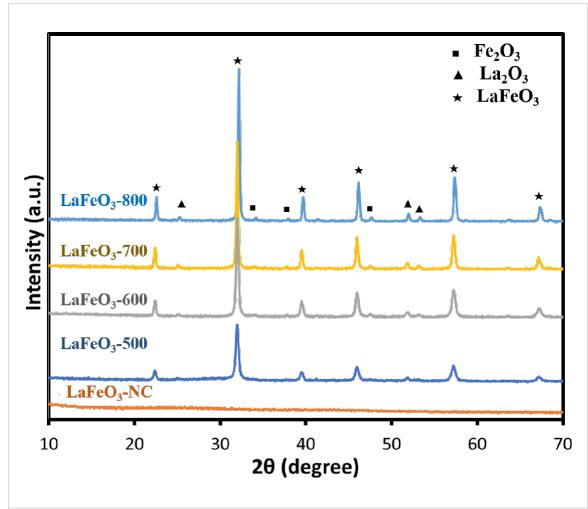
Figure 2: The characteristic XRD patterns of LaFeO 3 at different calci- nation temperatures. In addition, samples with various doping proportions of Fe/Ni, including 0.1/0.9, 0.3/0.7, 0.5/0.5, 0.7/0.3, and 0.9/0.1 were syn- thesized. The pH value was adjusted at 0 during synthesis, and the calcination temperature was fixed at 700 °C. The samples were named LaFeO 3 , LaFe 0.9 Ni 0.1 O 3 , LaFe 0.7 Ni 0.3 O 3 , LaFe 0.5 Ni 0.5 O 3 , LaFe 0.3 Ni 0.7 O 3 , LaFe 0.1 Ni 0.9 O 3 , LaNiO 3 to represent the different Fe/Ni doping ratios. In Figure 3, the #037-1493 [43] and JCPDS Card #033-0711 [41],